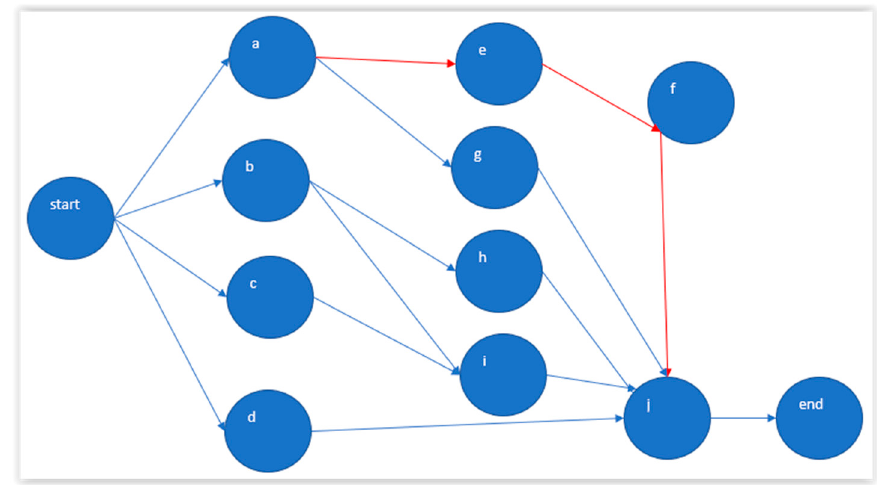
Figure 3. Critical path for knowledge about the EU.